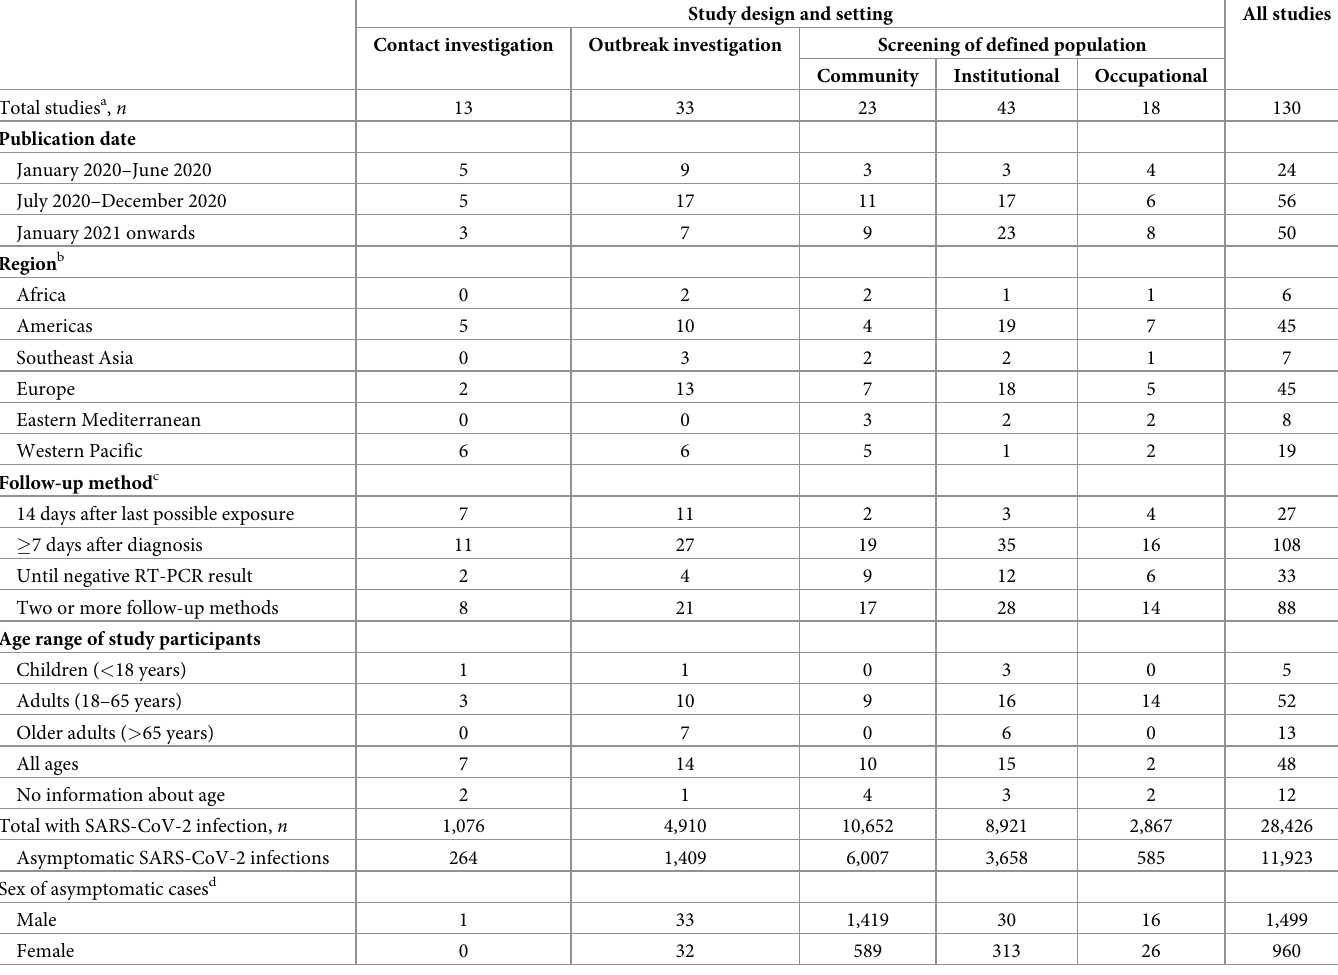
Table 1. Summary of characteristics of studies reporting on proportion of asymptomatic SARS-CoV-2 infections (review question